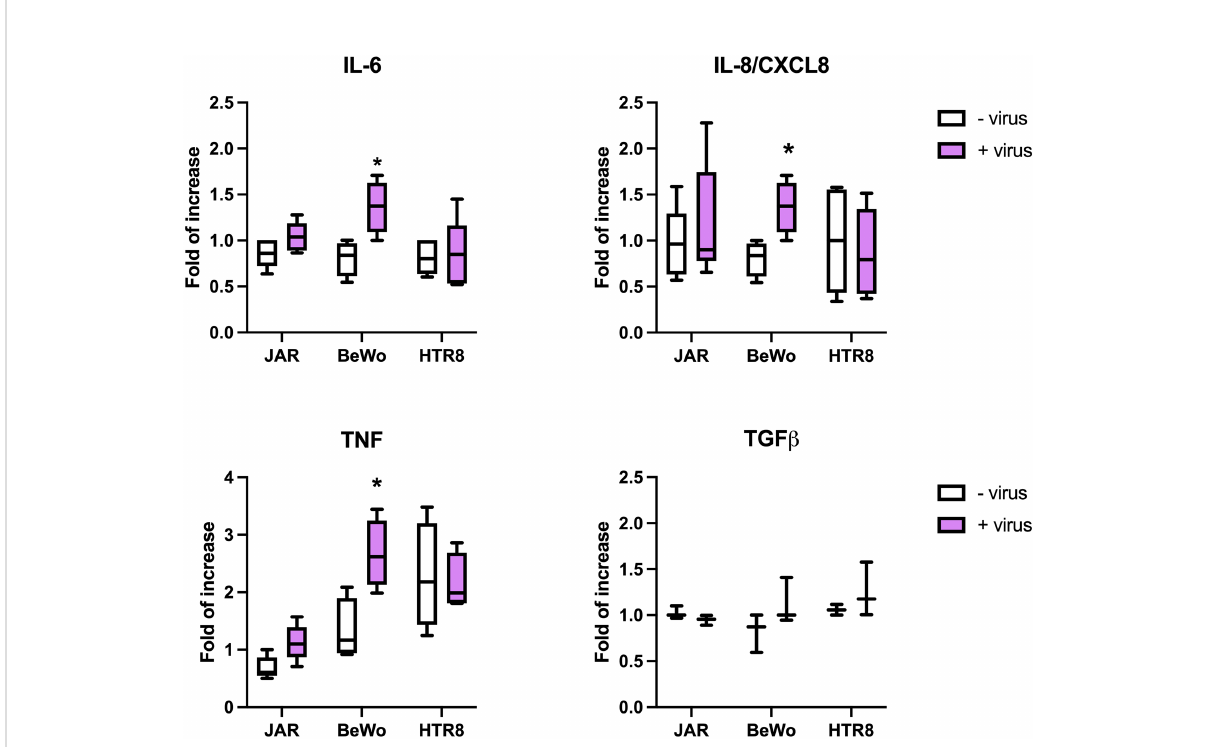
FIGURE 9 Evaluation of cytokine expression induced by SARS-CoV-2. The placental cells were challenged for 24 hours with SARS-CoV-2; total RNA was isolated and analyzed by RT-qPCR for the expression of IL-6, IL-8, TNF- a and TGF- b . The expression was normalized against the housekeeping genes 18S, ACTB and GAPDH ; results were mediated and expressed as fold increase . Data are expressed as mean ± SD of two independent experiments performed in triplicate. *p <